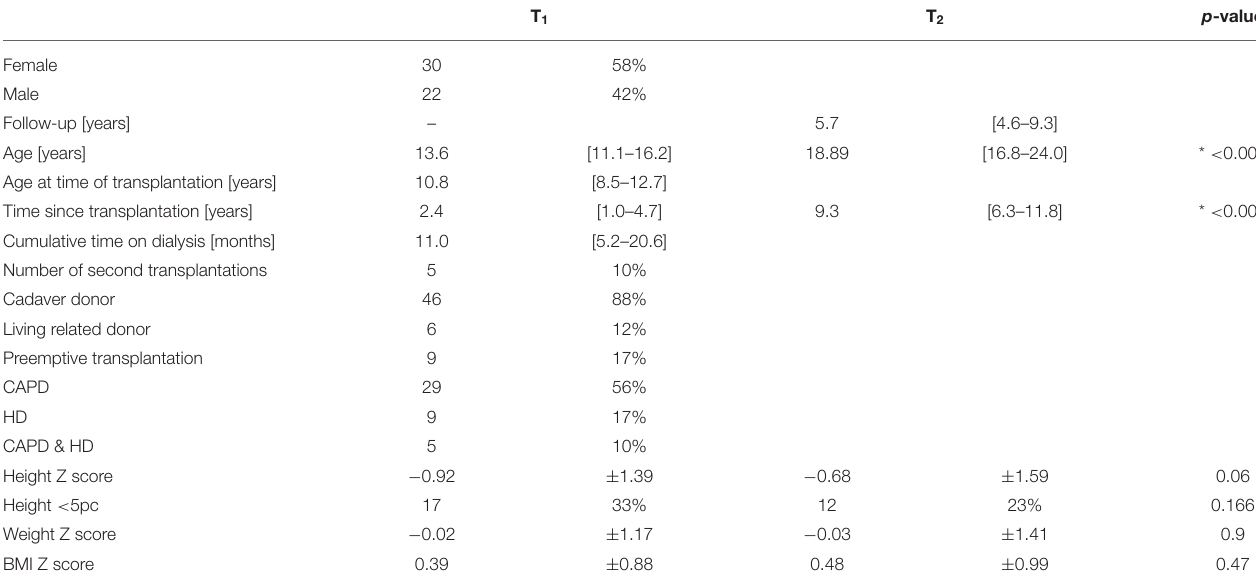
TABLE 1 | Patient characteristics at T 1 and T 2.